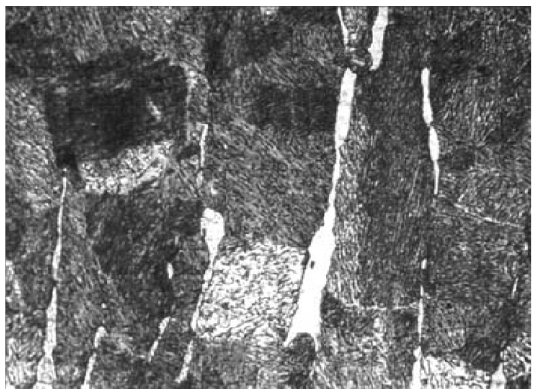
Fig. 11. Microstructure of aging samples at 700 o C for 4 hours (500X)